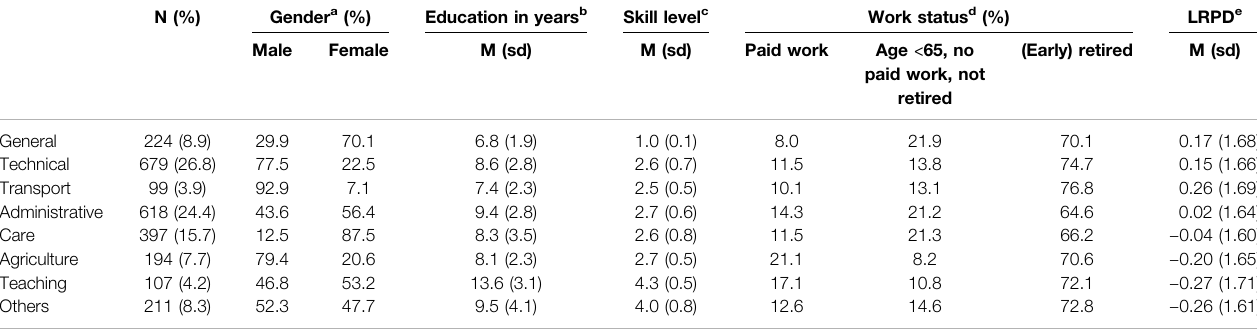
TABLE 1 | Socio-demographic characteristics of the occupational domains selected. Source: Longitudinal Aging Study Amsterdam, 1992 – 93 ( n (cid:1) 2,531). N (%) Gender a